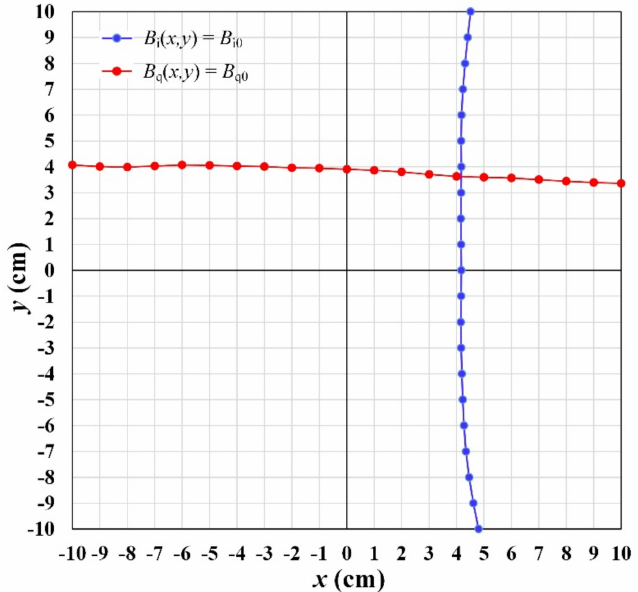
Figure 8. The two contour lines corresponding to B i 0 and B q 0 plotted by using the cubic interpolation algorithm. The sensor position is determined by the intersection of two contour